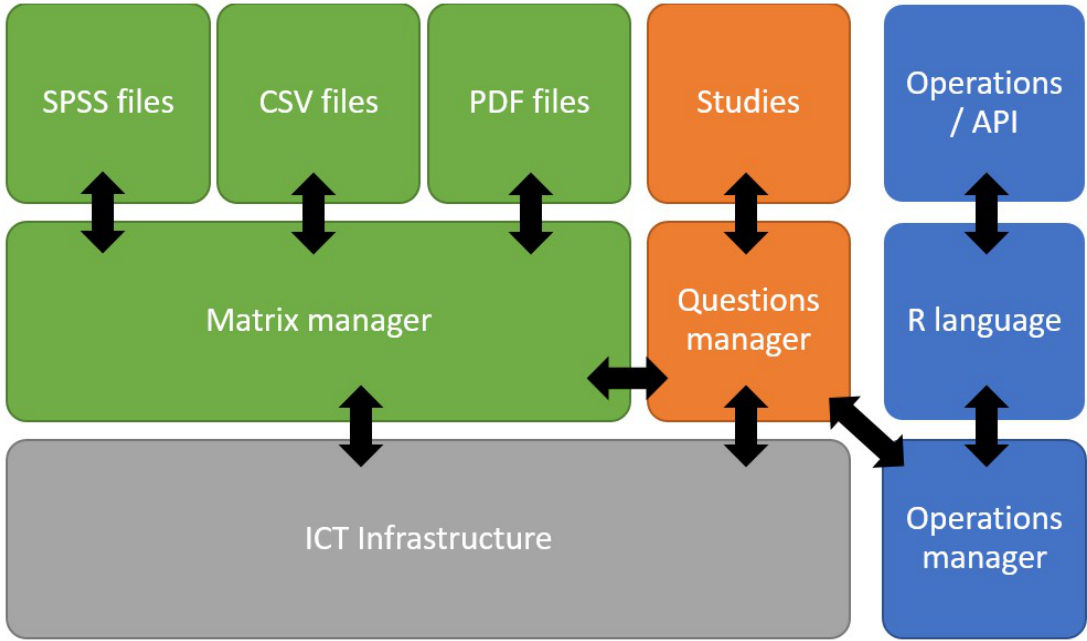
Figure 3. Proposed architecture for the management of statistical information. The Information and